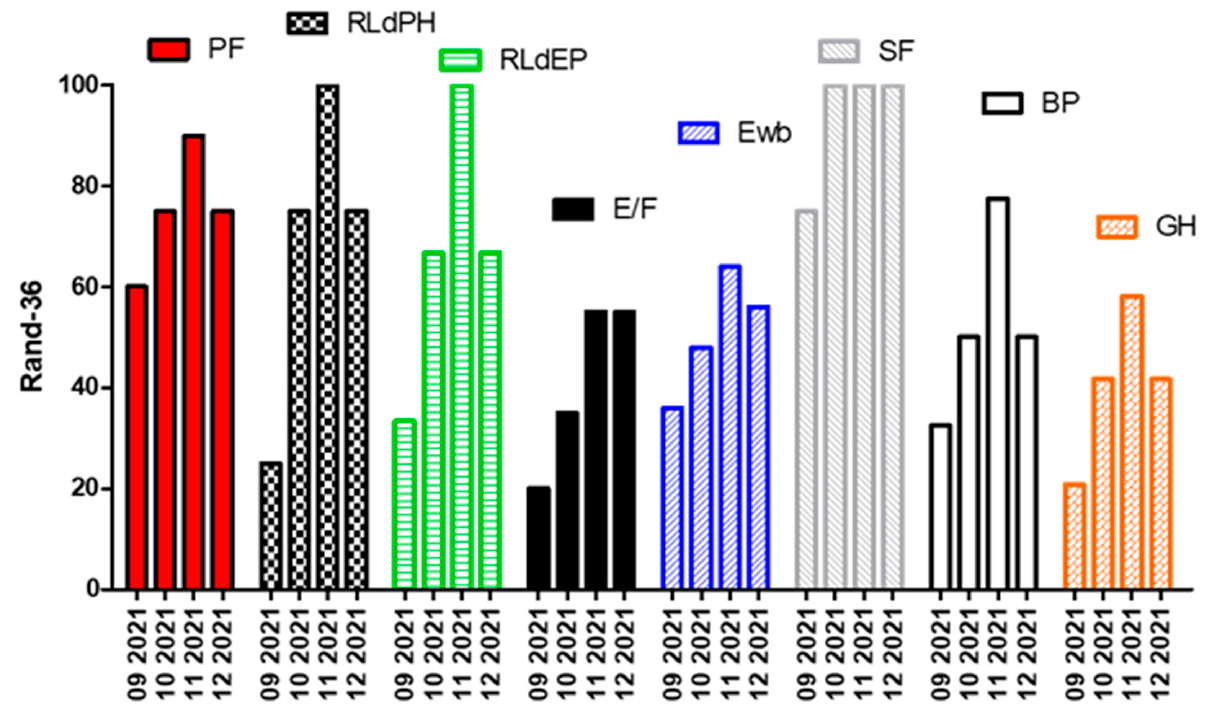
Figure 2. Rand-36 questionnair results: PF, Physical Functioning; RLdPH, Role Limitations due to Physical Health; RLdEP, Role Limitations due to Emotional problems; E/F, Energy/Fatigue; Ewb, Emotional well-being; SF, Social Functioning; BP, Body Pain; GH, General Health.